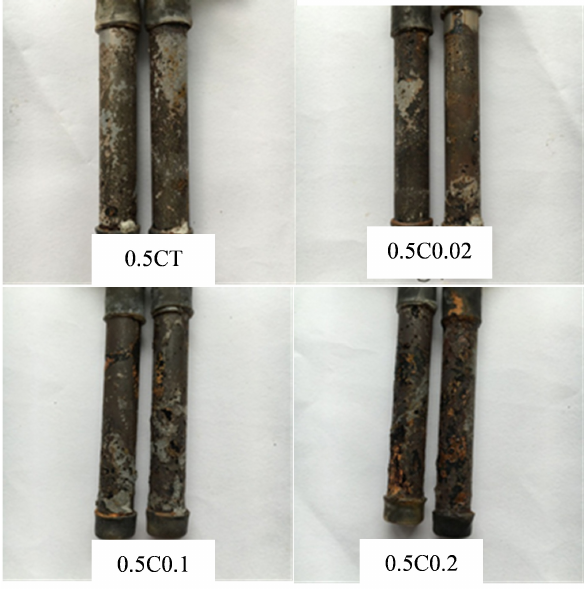
Figure 10: Corrosion condition of